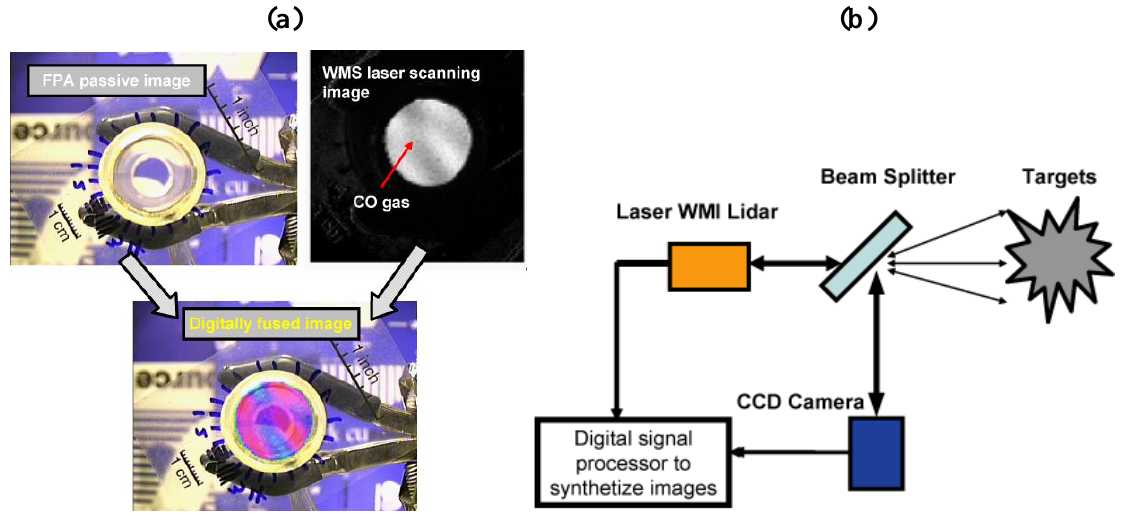
Figure 16. (a) Top left: a CCD visible image of the CO gas tube. Top right: the 2 nd order wavelength modulation spectroscopy (WMS) image of the entire scene, measured at the 4.88693  m, showing only the signature of CO absorption, since all other objects have negligible 2 nd order WMS signals. Bottom: a synthetic image, obtained by digital combination of the CCD visible image in top left with the 2 nd order WMS image in top right. (b) Concept diagram of a combined passive and active imaging system that would allow synthetic images such as the bottom of (a)